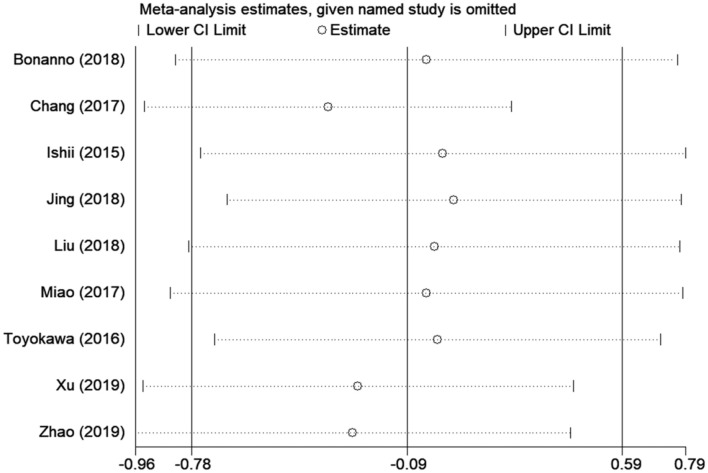
Sensitivity analysis of PD-L1 and OS.